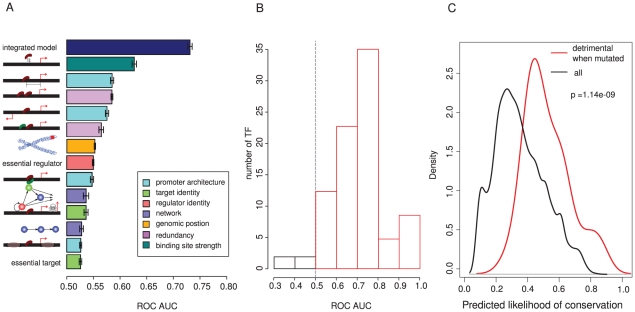
An integrated model provides good predictive performance of binding site conservation between species.(A) Predictive performance of individual features associated with binding site conservation, and of the final integrated model evaluated using ten-fold cross-validation and quantified using the area under the curve (AUC) of a receiver operating characteristic (ROC) plot. Mean and standard error of the AUC is shown for each feature. (B) The distribution of AUC values for the integrated model evaluated individually for each of 119 TFs. This shows that the same features provide good predictive performance for the conservation of binding sites for most TFs in a genome. (C) Comparison of the distribution of integrated model prediction scores for a subset of 44 binding sites where mutation of the site has been determined experimentally to be detrimental (see Materials and Methods) to the overall distribution of sites. Density is the probability density function of each distribution estimated using the 'density' function of R. The integrated model was constructed using a generalized linear model as described in the Materials and Methods.